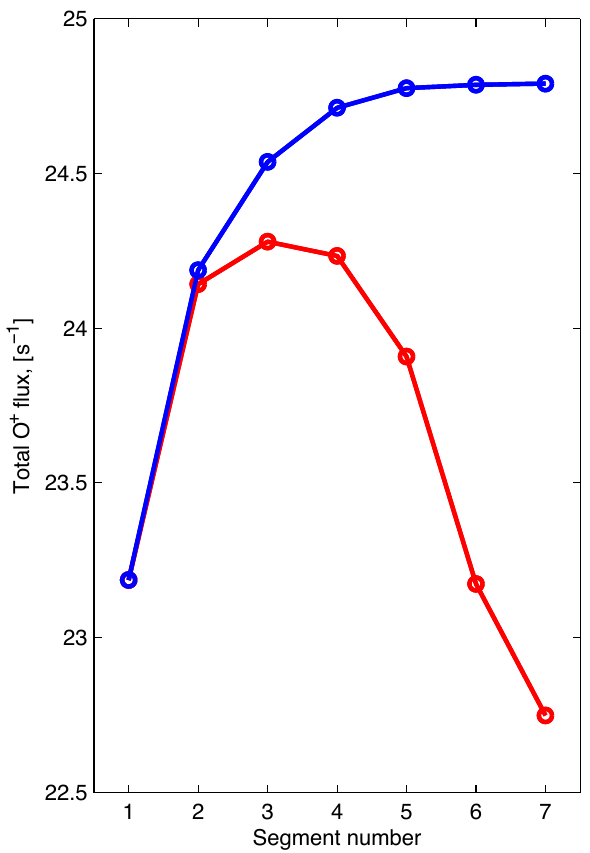
Fig. 4. Average escape flux for respective segment (red curve; see Fig. 1) and the total escape flux (blue curve). The total escape flux is calculated by summarizing the flux from respective segment in the sunward